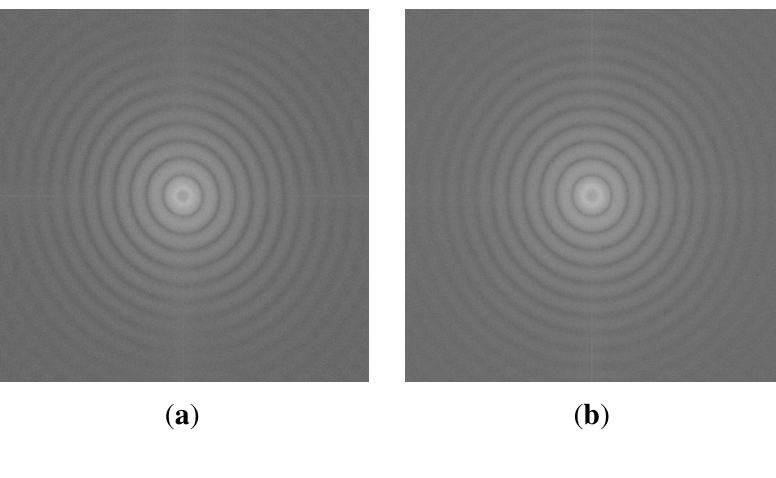
Figure 6. Fourier spectrum of the PS NP self-assembly on Si/PEI/(PSS/PAH) 2 ( a ) and PDMAEMA brushes ( b